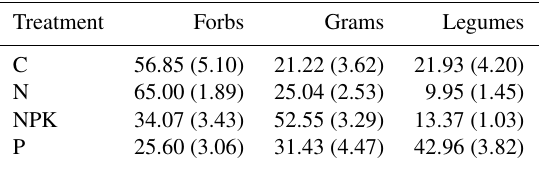
Figure 1. Daily average PAR, temperature (a) , soil water content for different treatments and total rainfall (b) recorded on the site during the experimental period. Dates of field measurements are indicated by vertical dashed-dotted lines.